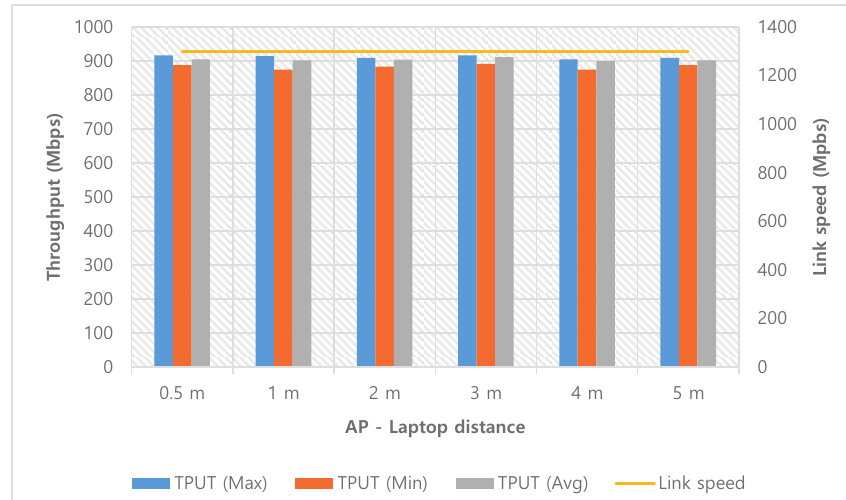
Figure 5. Throughput performance of WiFi at various